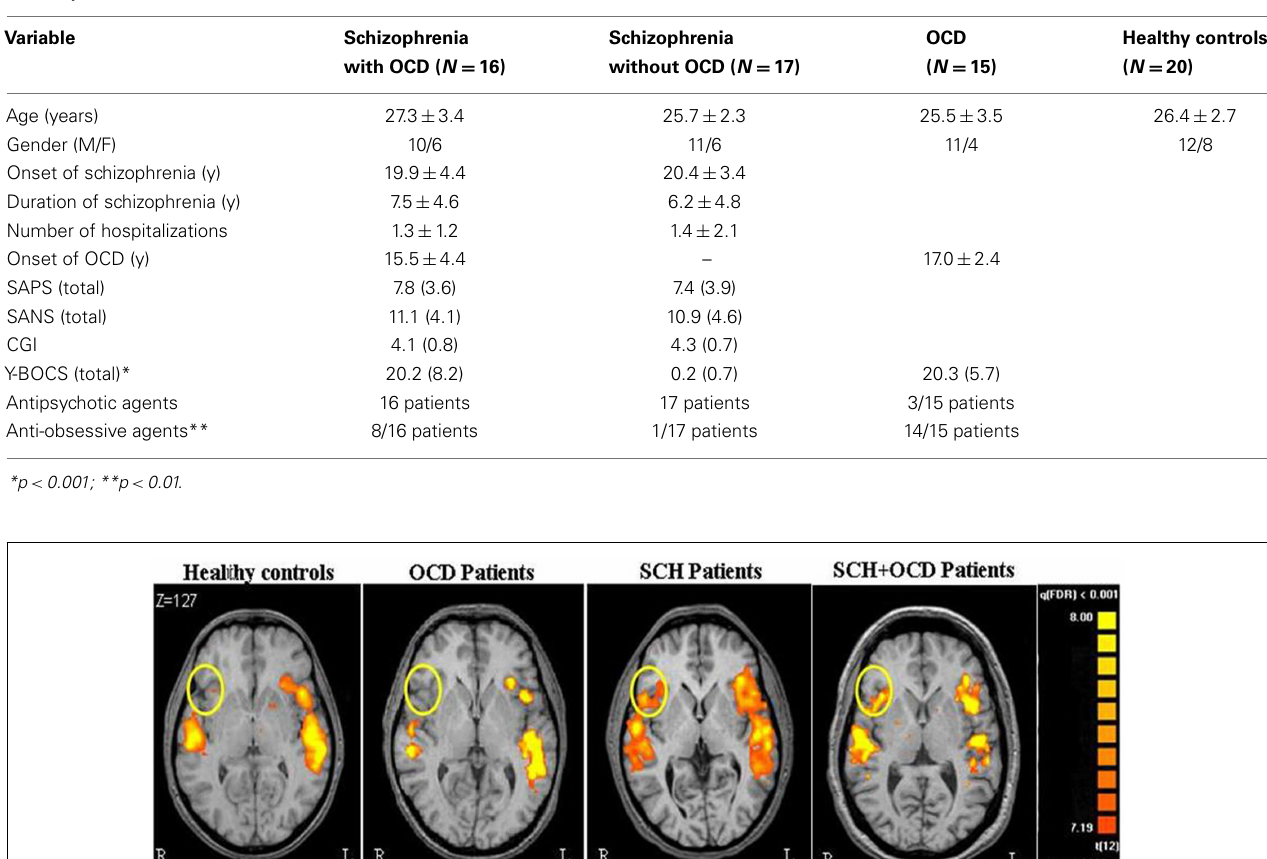
Table 1 | Demographic and clinical characteristics of the study participants .